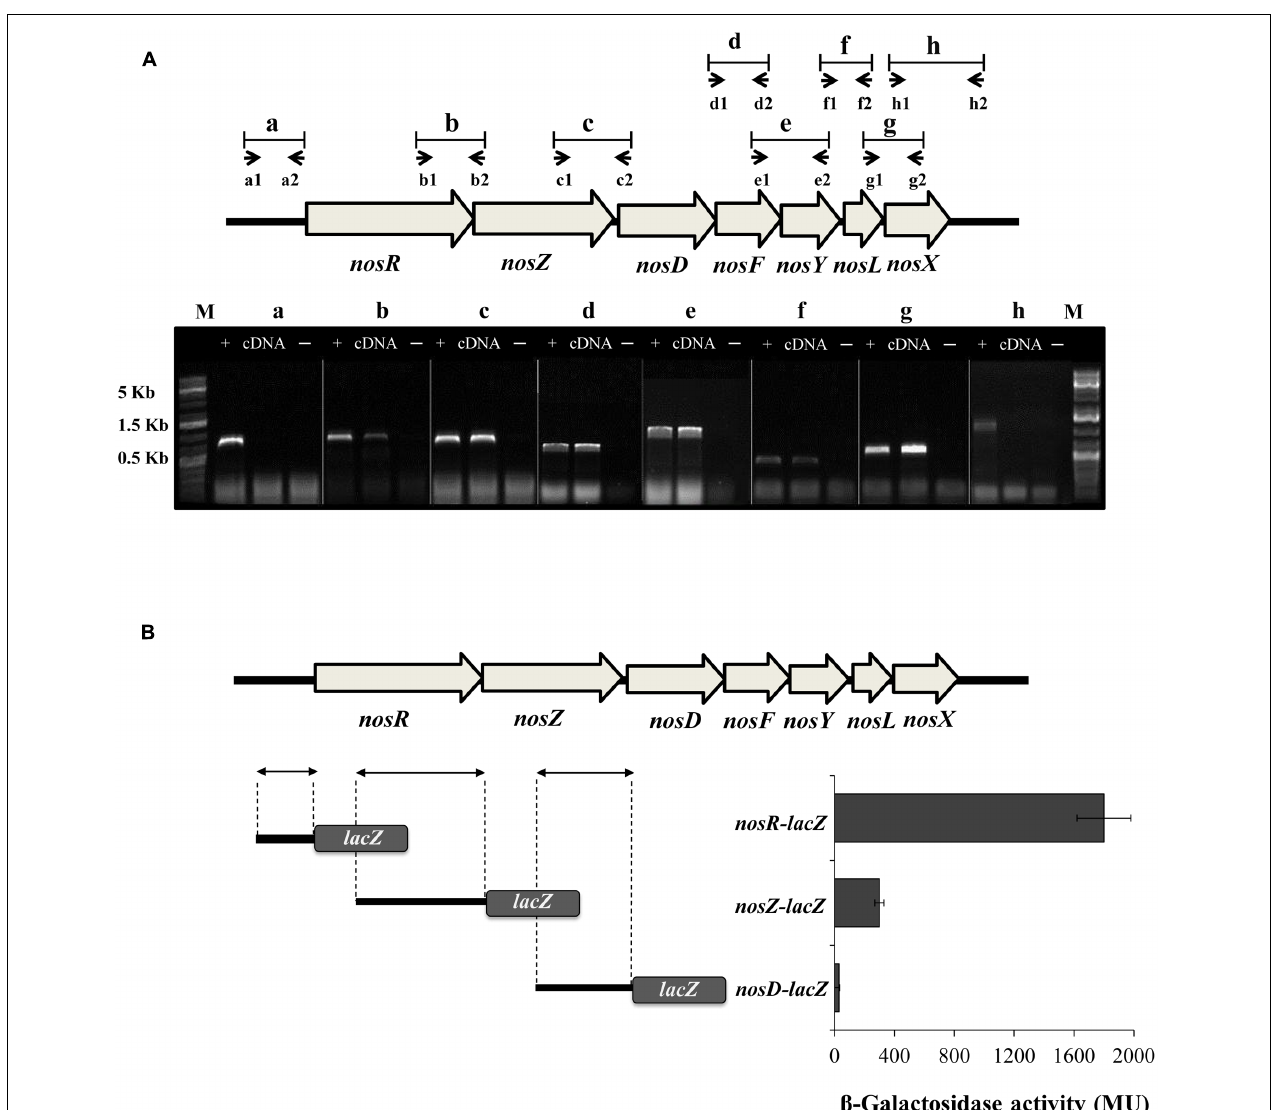
FIGURE 1 | Transcriptional organization of the B. diazoefficiens nosRZDFYLX genes. (A) Putative intergenic regions probed by RT-PCR are labeled as “b-to-g” and the small arrows below depict positions and orientation of the PCR primers used for each intergenic region. Combinations of primers a1/a2 and h1/h2 were used to amplify “a” and “h” flanking regions. Primer sequences are shown in Supplementary Table S1. RT-PCR products of each primers’ pair combination were loaded on an agarose gel. Total RNA served as the template for cDNA synthesis by using gene specific primers that hybridize in the complementary sequence of nosD and nosX genes. PCR amplifications using genomic DNA as template (+) or without reverse transcriptase (–) served as positive and negative controls, respectively. The sizes of the marker (M) bands are labeled on the left side. (B) β -galactosidase activity from the DNA regions upstream of nosR, nosZ, and nosD genes fused to the lacZ reporter gene (on the right). On the left, the DNA regions fused to lacZ are depicted by arrows. In (A,B) , B. diazoefficiens wild-type (WT) cells were grown for 24 h under low oxygen conditions (initial 0.5% O 2 ) with 10 mM KNO 3 . Data expressed as Miller units (MU) represent mean values and error bars from triplicate samples from at least two independent